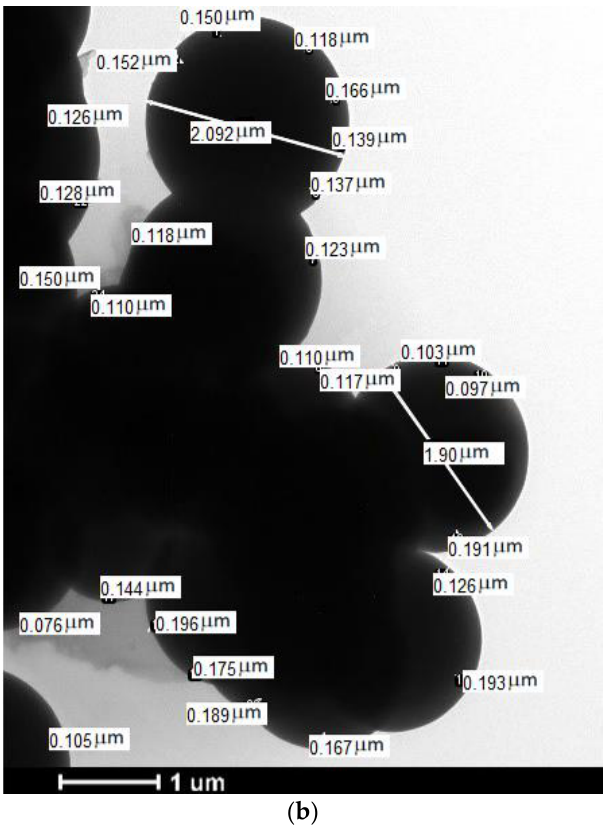
Figure 9. Trial-4 microcapsule TEM images at scales of ( a ) 500 nm and ( b ) 1µm.